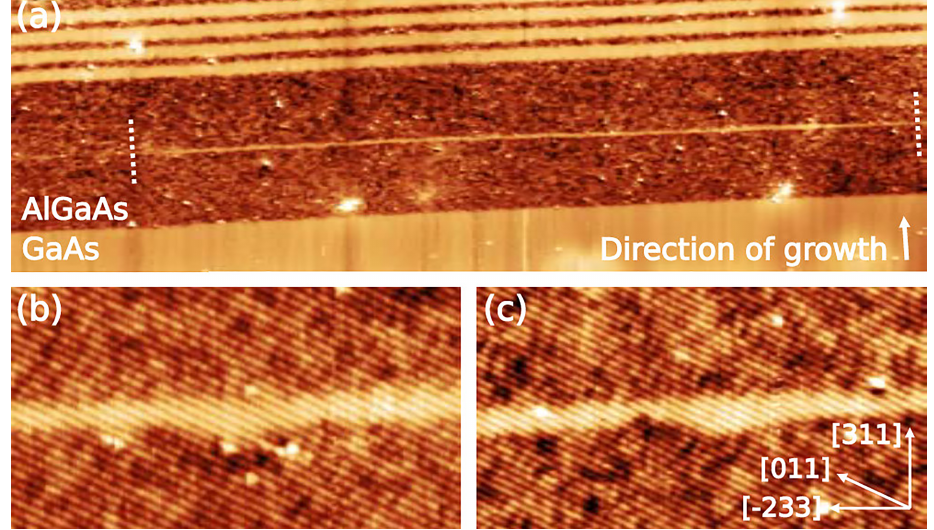
Figure 14. ( a ) 250 × 75 nm 2 topographic X-STM image of one complete QWR (marked by the two dashed lines). ( b , c ) 30 × 16 nm 2 close ups of the interface fluctuation. Reprinted from Ref. [75], © 2011 with the permission of AIP